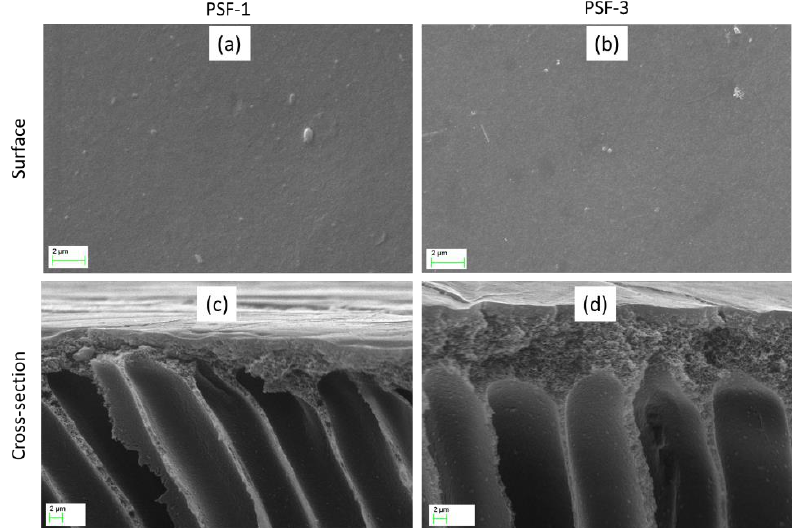
Figure 2. SEM images of the polysulfone (PSF) membranes with different additive (PEG) loading; magnification of 10,000× for the surface of ( a ) PSF-1 and ( b ) PSF-3; magnification of 500× for the cross-section of ( c ) PSF-1 and ( d ) PSF-3.